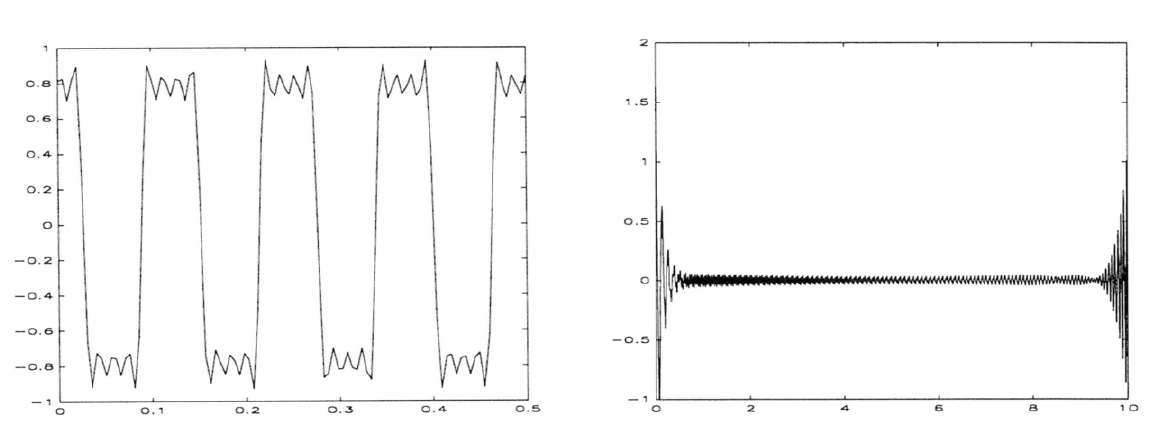
FIGURE 6 Sampled square wave with seven har monics.